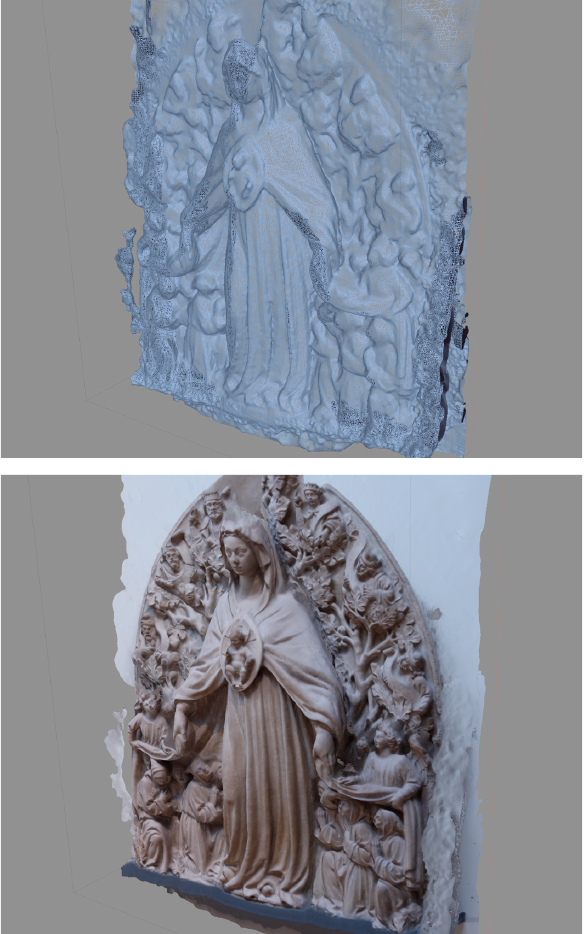
Figure 5-6: a detail of the output mesh of the London